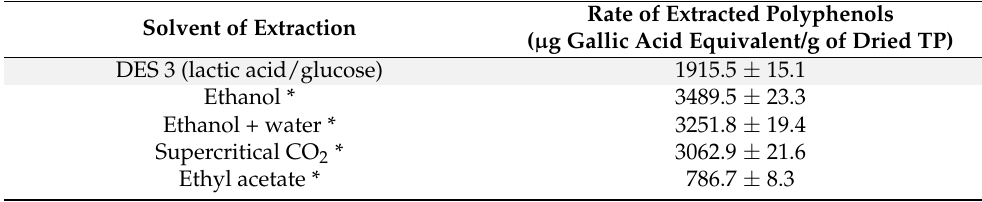
Table 5. Comparison of extracted polyphenol rates from tomato